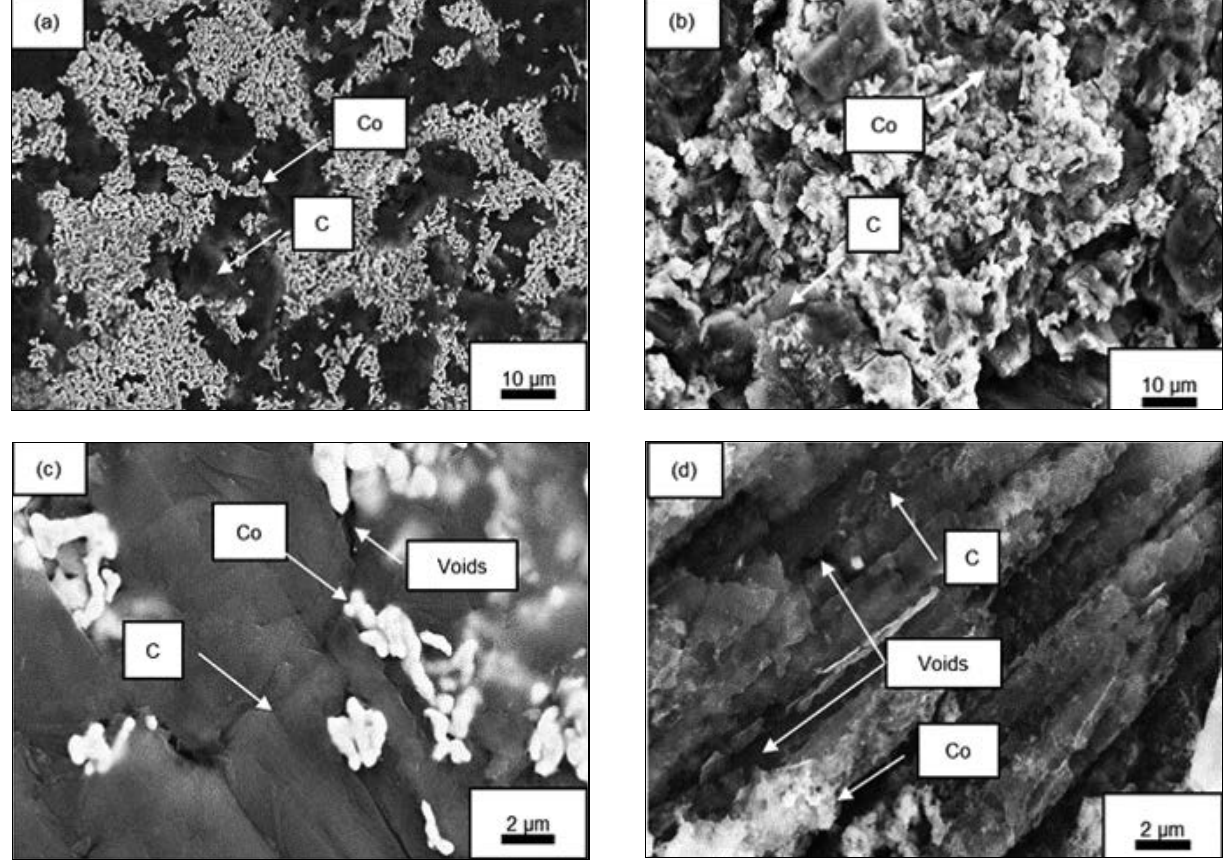
Figure 6. FESEM micrograph of Co 47.5 /C 47.5 -PVC 5 electrode (a and c) fresh and (b and d) after electrolysis of synthetic textile effluent by using (a and b) 1000x and (c and d) 5000x magnification. ([RB21] o = 50 mg L –1 ; [NaCl] = 0.5 mol L –1 ; t = 45 min; E = 20